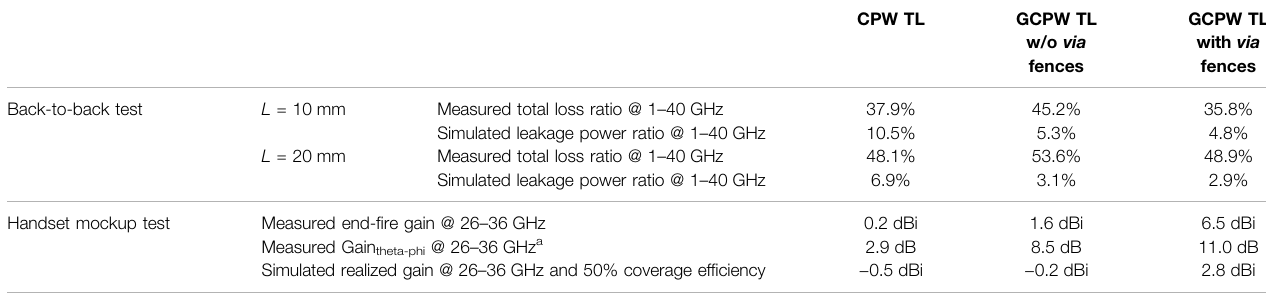
TABLE 1 | Performance comparison (averaged value) of the phased array antennas containing three types of feeding networks.